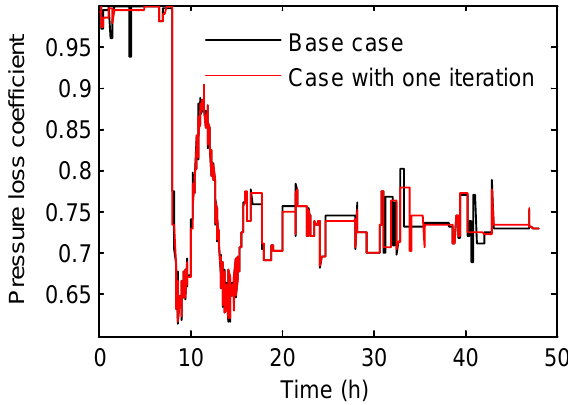
Figure 9. Fault diagnosis of fault 7 with one iteration only.